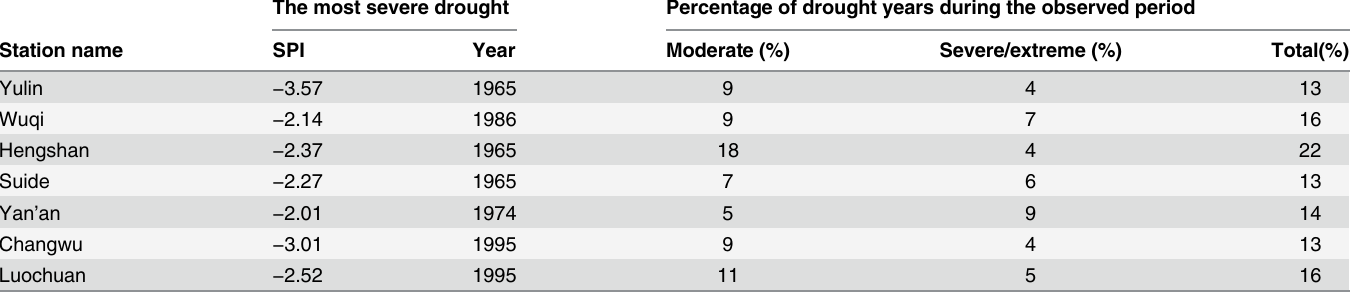
Table 8. Characteristics of droughts at 12-month time